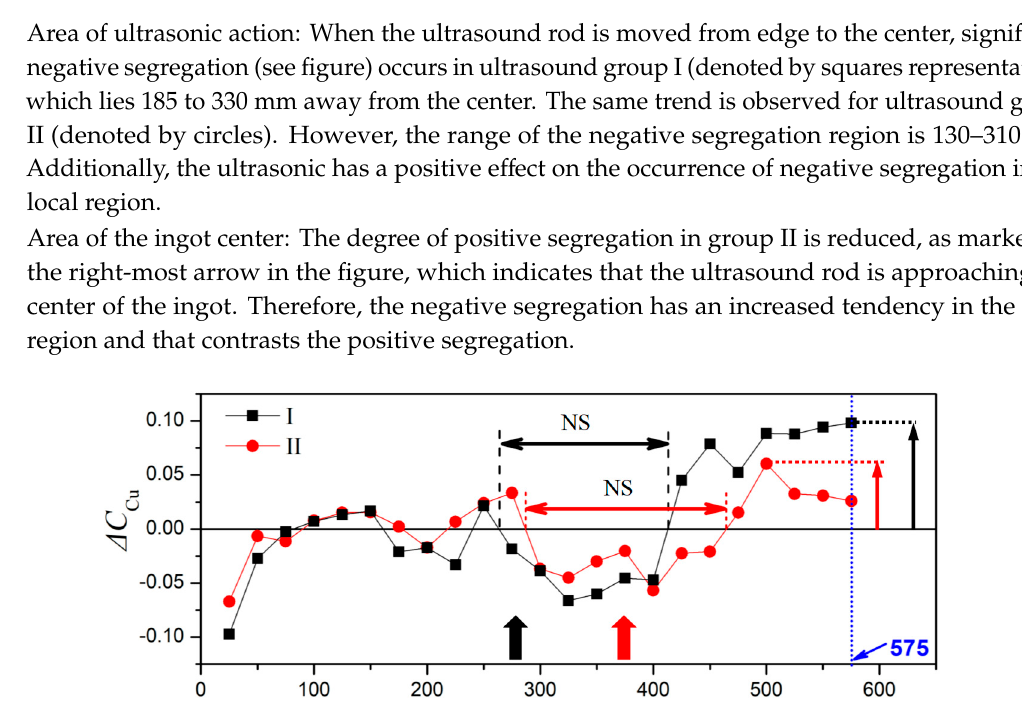
Figure 10. Segregation curves corresponding to the two groups of ultrasonic ingots with a diameter of Φ 1250 mm.